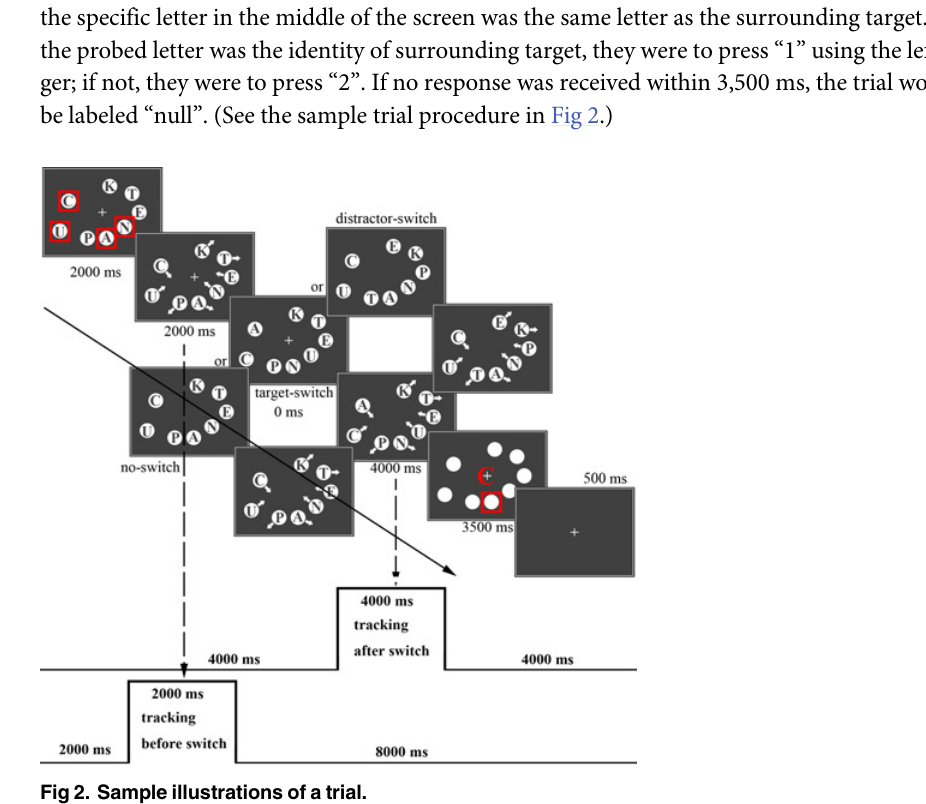
Fig 1. The stimuli used in the experiment. The dark grey background of this picture is to highlight the rim of each white circle.